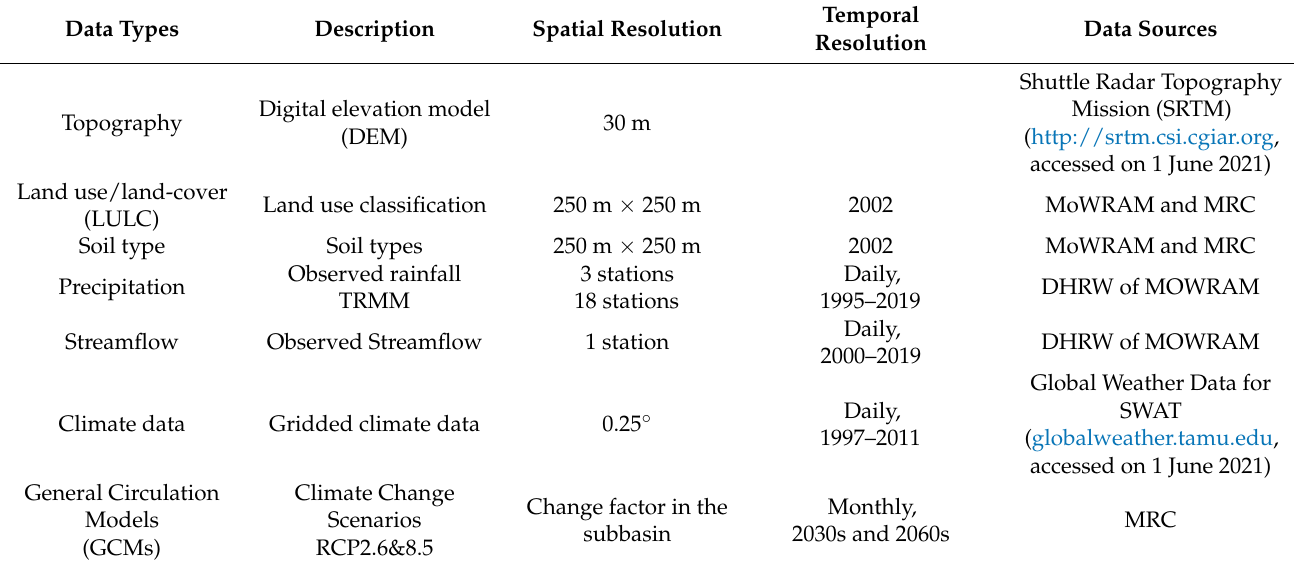
Table 1. Data input and sources in the SWAT model in this